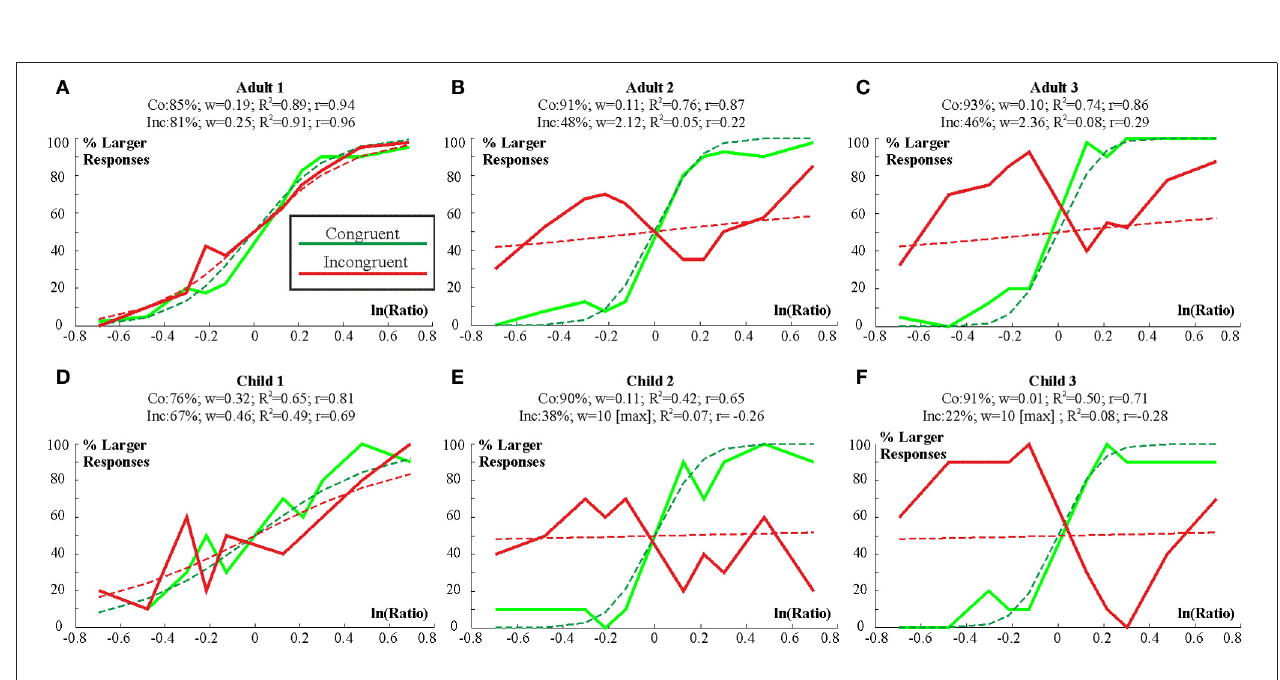
FIGURE 7 | Individual decision curves for 3 adult (A–C) and 3 child participants (D–F). Empirical decision curves are shown by thick lines. Model decision curves are shown by thin dashed lines. Figure titles show the